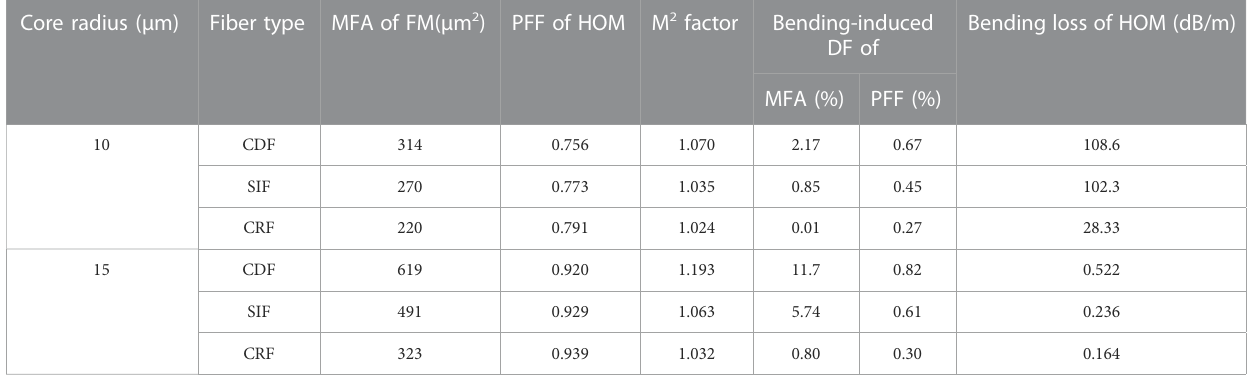
TABLE 3 Calculated results for three kinds of fi